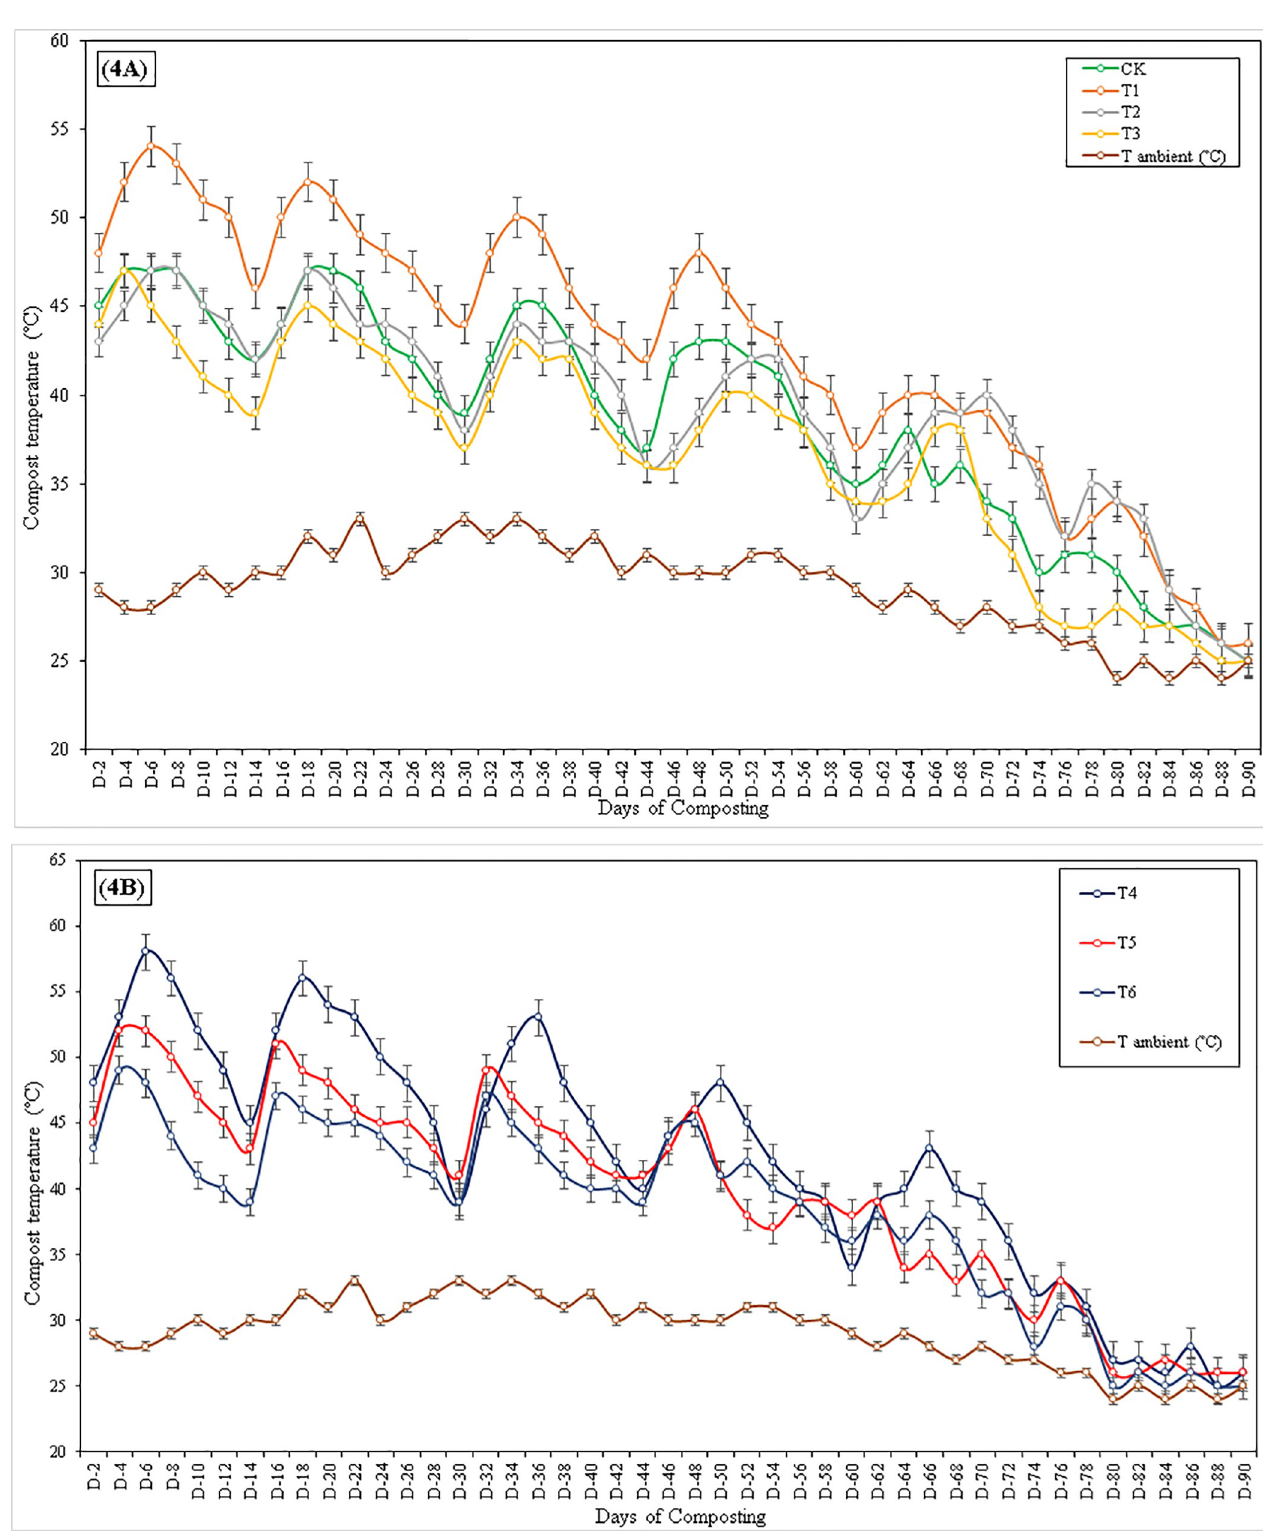
Fig 4. A and B Measurement of ambient and compost material temperatures; 4A) Composting treatments without inoculum, 4B) Composting treatments amended with SSA inoculum.